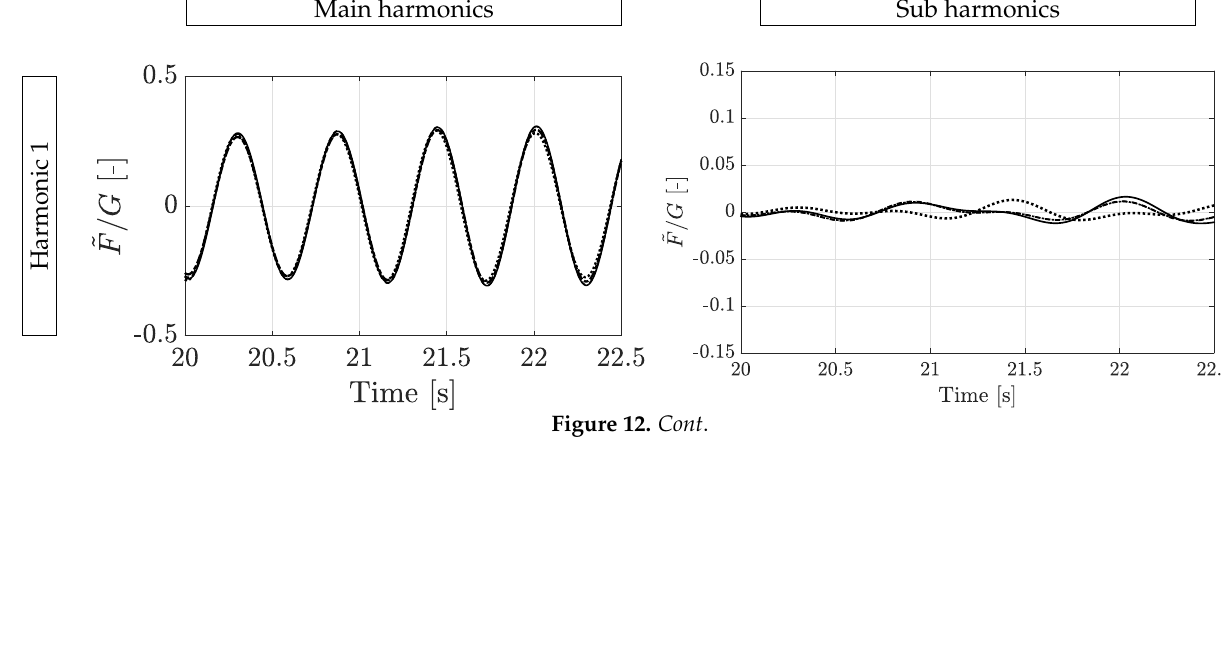
Figure 11. Comparison of the measured (solid line) and reconstructed contact force using RM I (dashed line), RM II (dash-dotted line), or RM III (dotted line): ( a ) relevant zoom of the time series and ( b ) amplitude spectrum. Main harmonics Sub harmonics